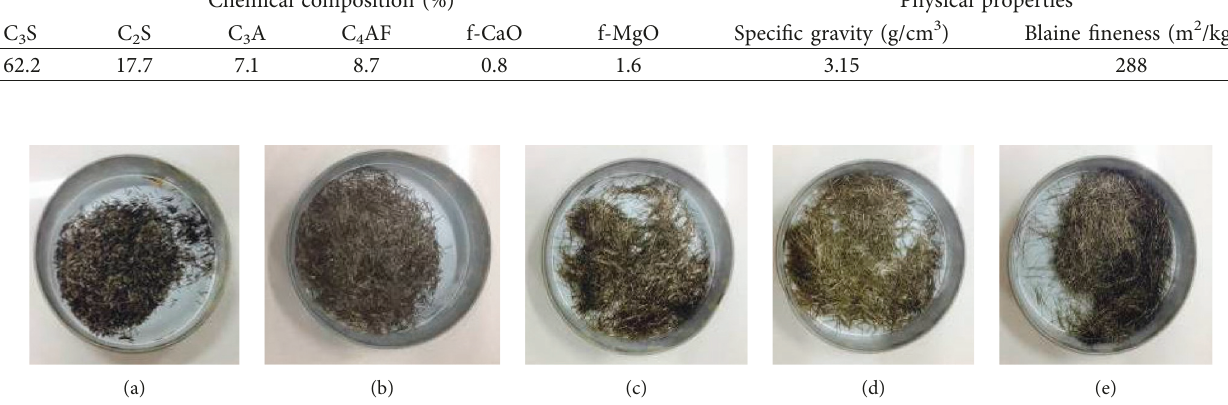
Figure 1: Short-cut basalt fibers with different lengths: (a) L � 12mm, (b) L � 18mm, (c) L � 24mm, (d) L � 30mm, and (e) L �